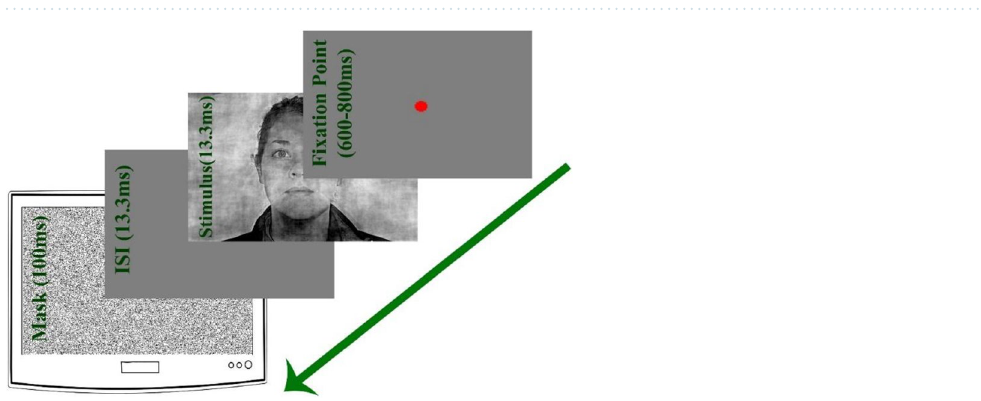
Figure 4. The sample of used images in the model and psychophysical test. The upper row is face and the lower row is house with different noise levels.